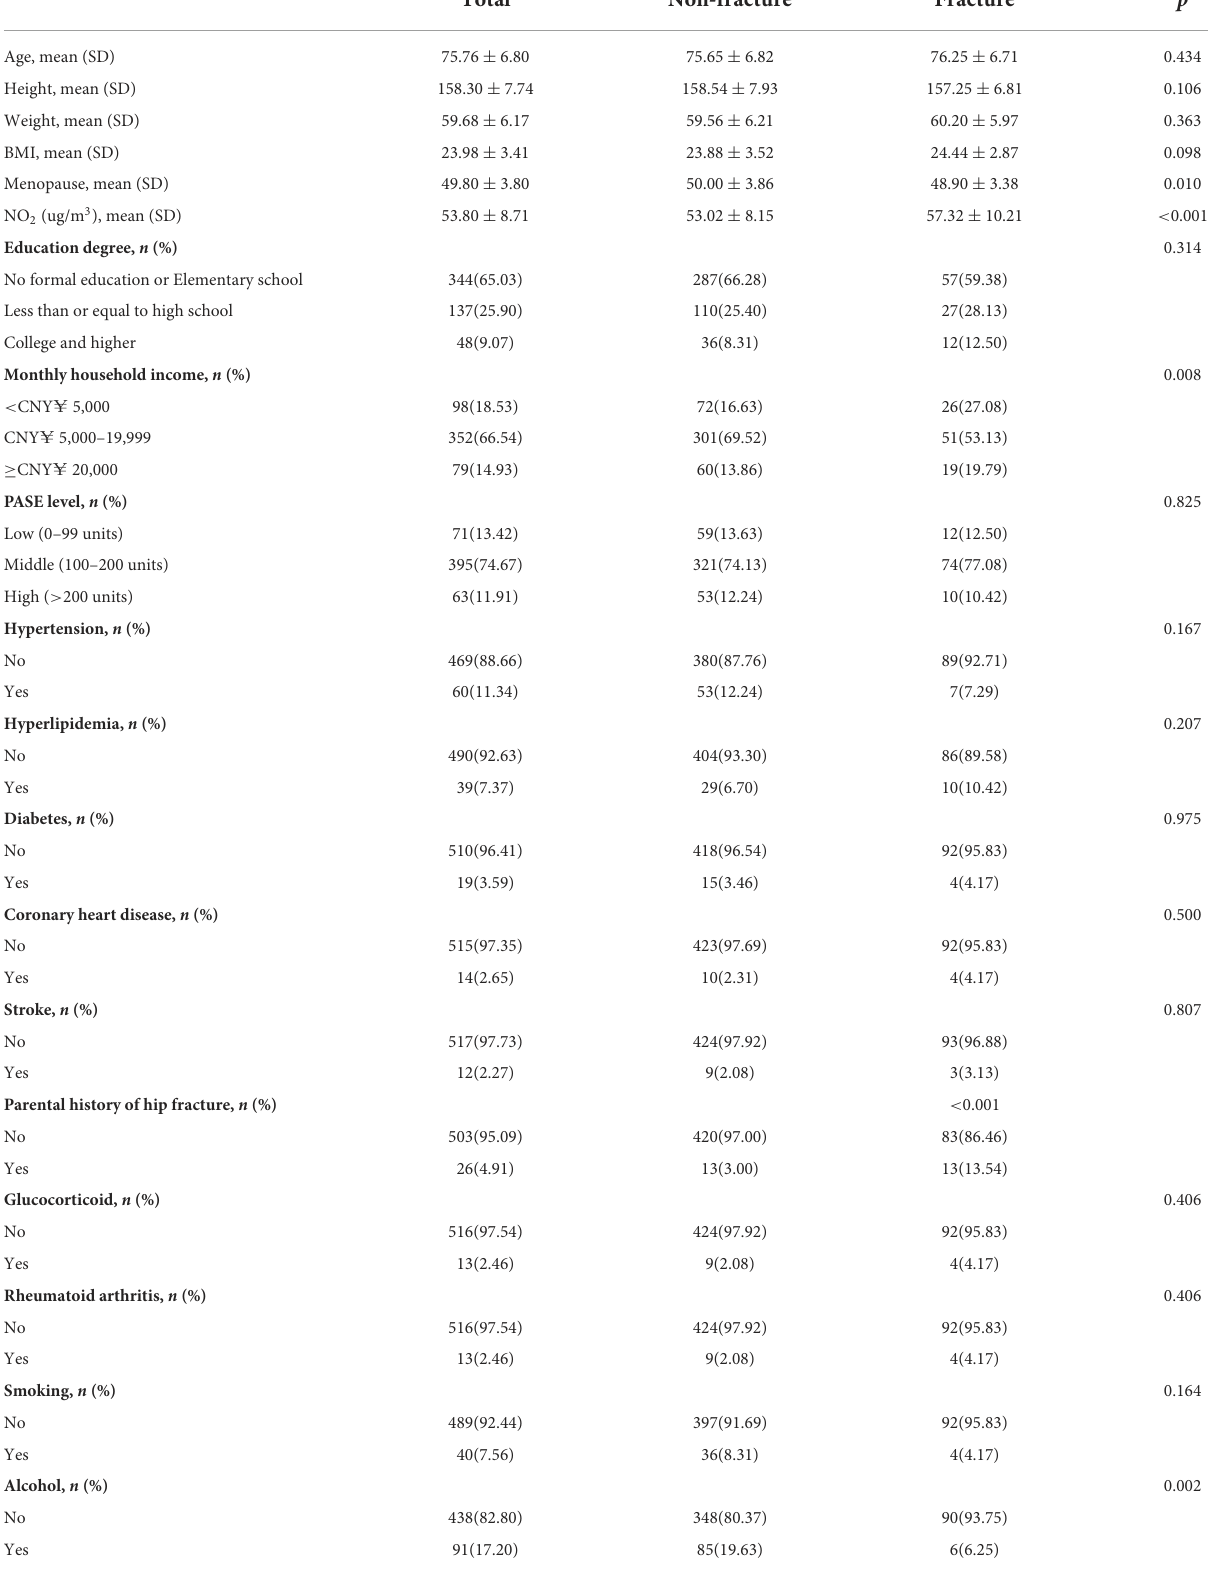
TABLE 1 Demographic, physical, and clinical characteristics at baseline in the BONE study cohort.